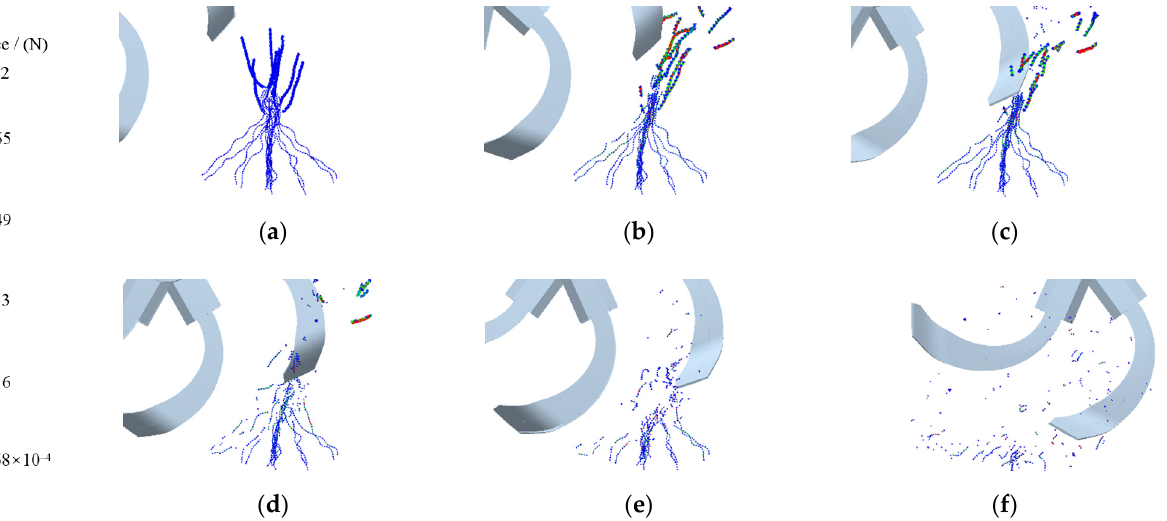
Figure 13. The crushing process of Cyperus esculentus plants. ( a ) 1.9 s; ( b ) 2.1 s; ( c ) 2.3 s; ( d ) 2.5 s; ( e ) 2.7 s; ( f ) 2.9